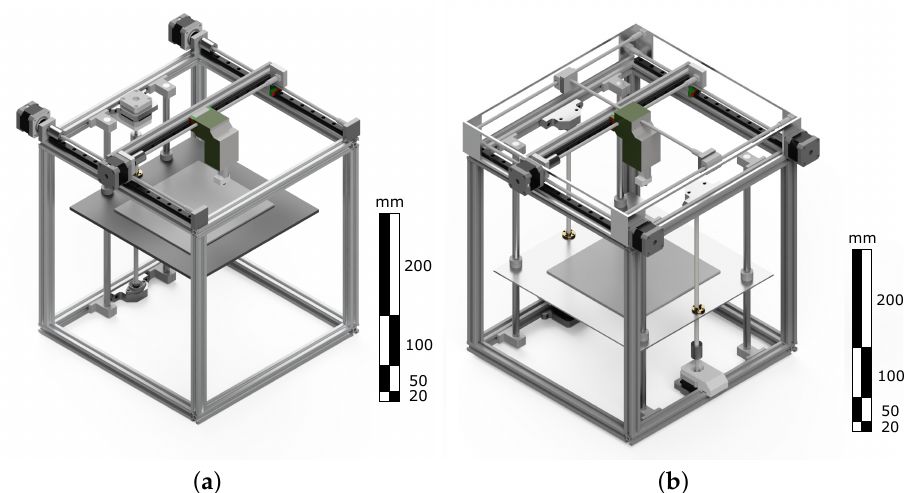
Figure A2. 3D model of 3D printers with fixed axes X B , Y B , Z H and actuated axes X H , Y H , Z B ( a ) with closed X H , Y H and open Z B axes ( b ) with closed X H , Y H , Z B